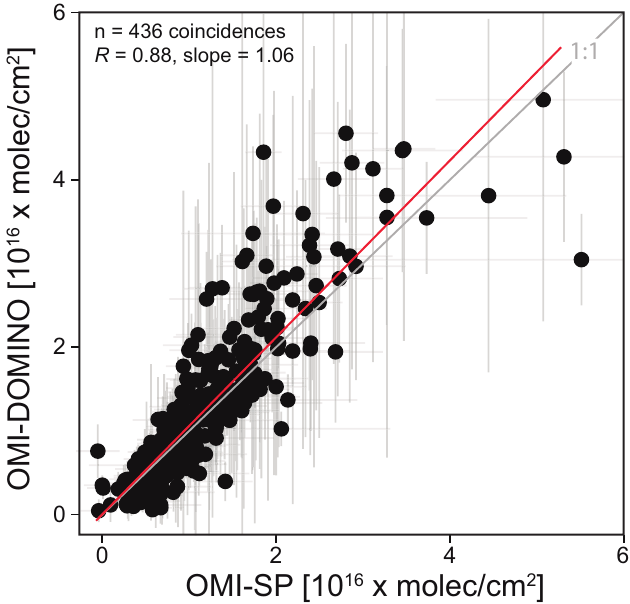
Figure 6. Correlation between the DOMINO (v2) vs the Standard Product (v3) from OMI NO 2 . Linear regression in red and error bars from each data product are shown in